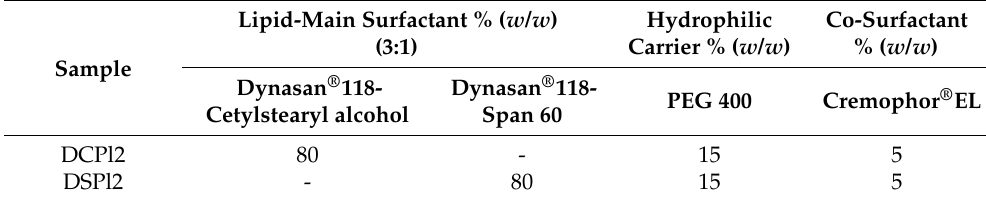
Table 2. Composition of the emulsions with Dynasan ® 118 as lipid.